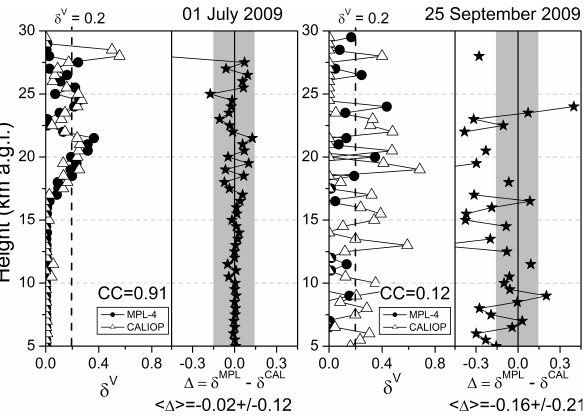
Fig. 9. The same as for Fig. 8, but for the CALIPSO D2 dis- tance range (20–30km). PSC events correspond to those cases with a high/moderate and low CC values as observed, respectively, on 23 August 2011 (left) and 3 July 2010